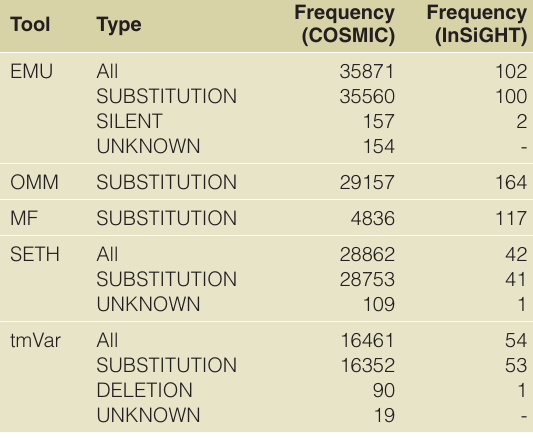
Table 21. Protein variants annotated by each mutation extraction, using all the sources from the articles, tool grouped by type. The type of each variant has been annotated using SETH, thus the variant types delivered by SETH are considered. The tools are Extractor of Mutations (EMU), OpenMutationMiner (OMM), MutationFinder (MF), tmVar and SNP Extraction Tool for Human Variations